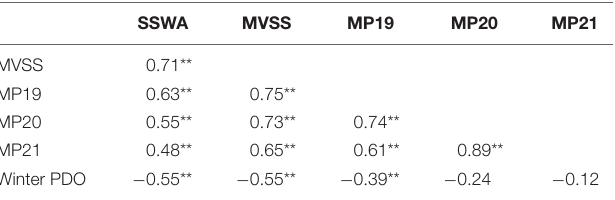
TABLE 3 | Correlations analyses between winter (December–February) PDO (Pacific Decadal Oscillation), and spawning ground indices (SSWA: suitability SST-weighted area of potential spawning ground, MVSS: mean values of suitable SST on dynamic potential spawning ground, MP: the meridional position of suitable SST isoline (e.g., MP19, MP20, and MP21).